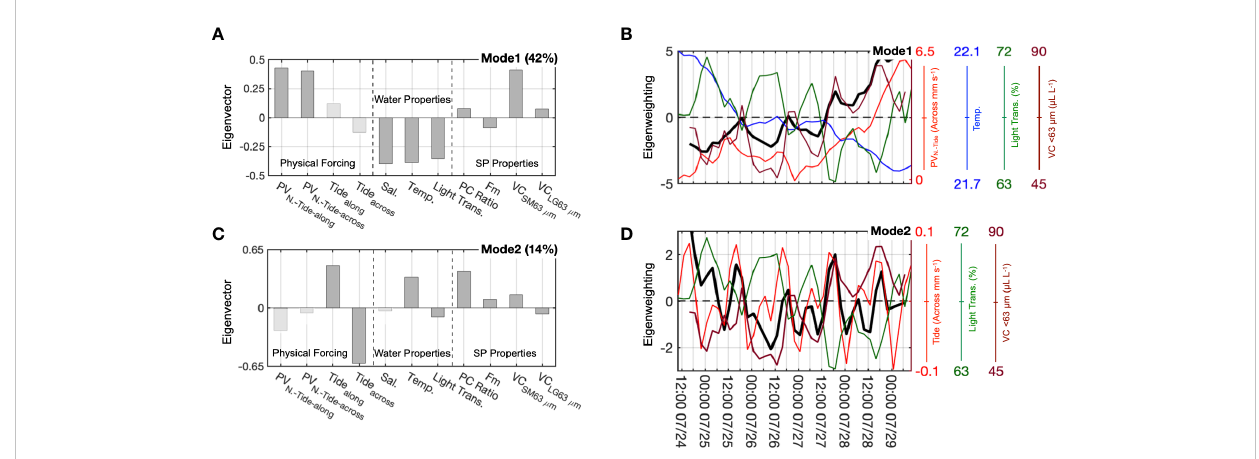
FIGURE 12 Plots of the EOF analysis of results. (A, B) Eigenvectors of the fi rst two modes. The dominant variables are in dark gray, and the rest are in light gray. The eigenweighting curve of each mode (bold black curve) is potted against the selected variables including (C) the across-shore non-tidal PV (red curve), temperature (blue), light transmission (green), and VCs in the <63 µm size class (brown); (D) the across-shore tidal fl ow (red), light transmission (green), and VCs in the<63 µm size class